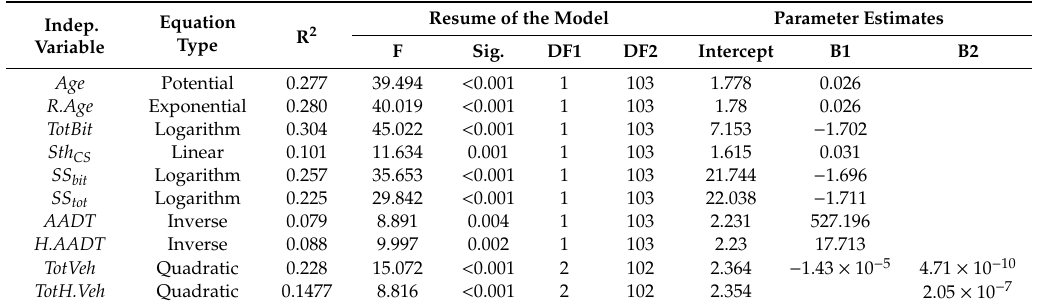
Table 4. Equations that best fit each independent variables individually with the dependent variable. Indep.